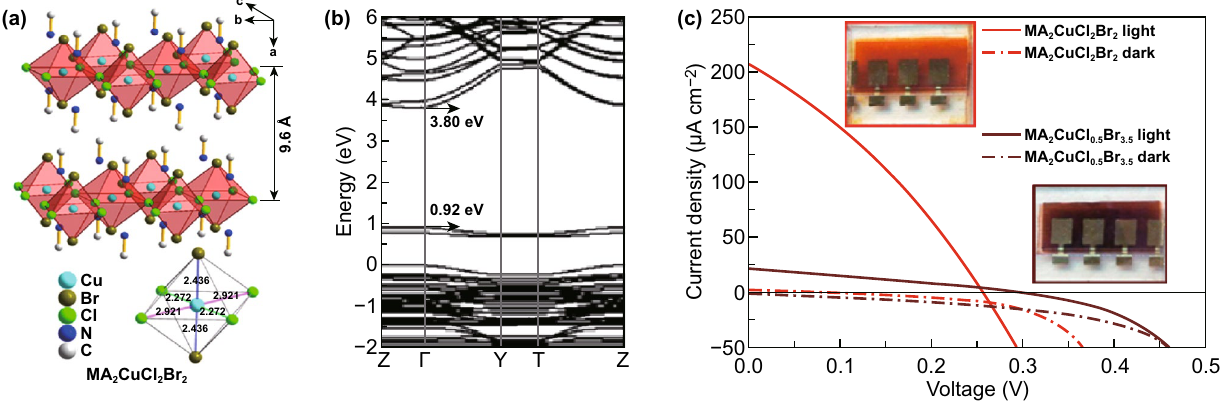
Fig. 10 a Crystal structure of MA 2 CuCl 2 Br 2 , showing the alternation of organic and inorganic layers and the Cu-X bond lengths in the inor- ganic framework. b Electronic band structure of MA 2 CuClBr 3 investigated by DFT simulation. c J – V curve of solar cells sensitized with MA 2 CuCl 2 Br 2 (red) and MA 2 CuCl 0.5 Br 3.5 (brown) under 1 sun of light illumination. The red and brown dashed lines represent dark current. Reproduced with permission from Ref.